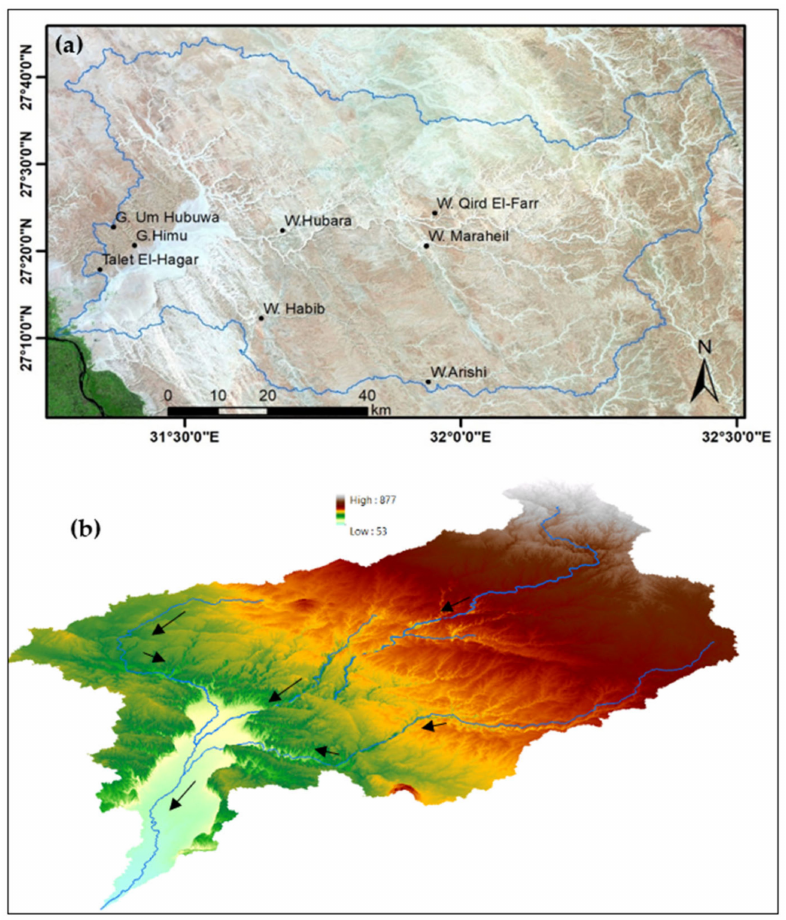
Figure 2. ( a ) Landsat mosaic overlaid with the W.Asyuti watershed; ( b ) 3D oblique view of Wadi Asyuti; ( b ) Rainfall storm on 8 to 9 March 2014 overlaid by the floodway extracted from Landsat data collected on 15 March